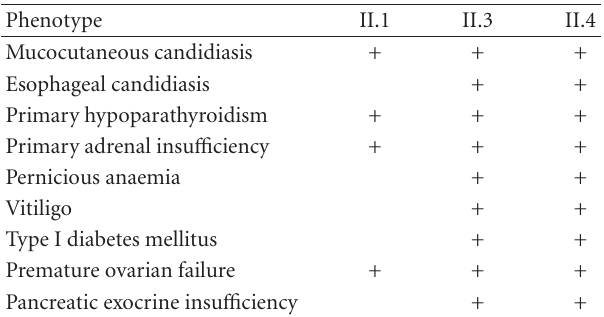
Figure 2: Chart showing variations in serum-corrected calcium concentrations (mmol/L) over time for Case II.4. Table 1: Phenotypic manifestations of APS1 in a ff ected family